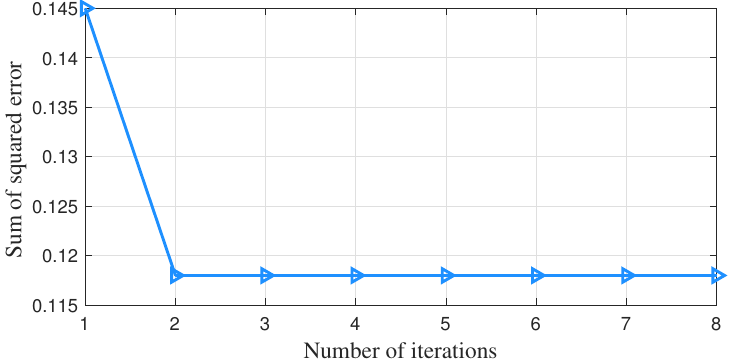
Figure 5. The change in the sum of the squared errors under the k-means++ algorithm.